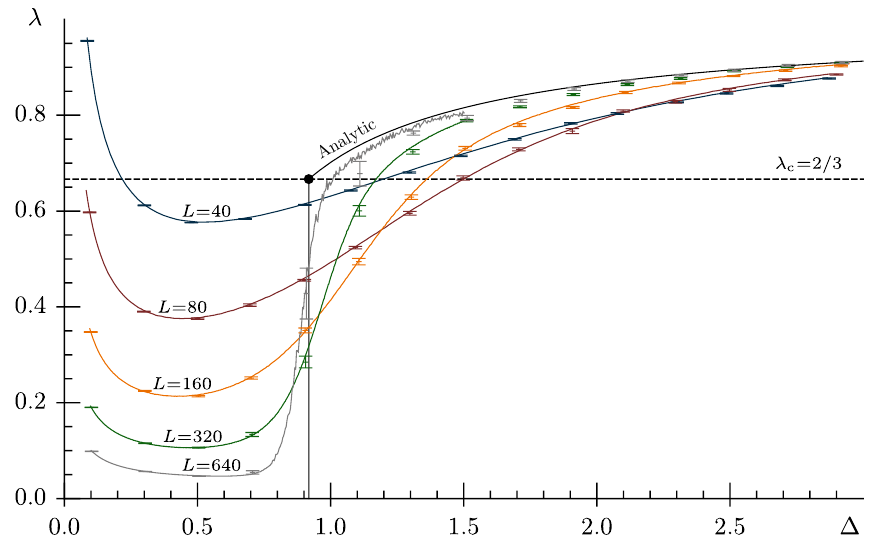
Figure 7: Droplet formation-dissolution transition at fixed T = 0.4, expressed in terms of the density parameter ∆ ( ρ , V ) and the droplet fraction λ ( ρ , V , N clude leading-order finite-size corrections. Individual points with error bars stem from M ETROPOLIS simulations and continuous lines are reweighted from M UGC . Strong finite-size effects are apparent in the gas phase but with respect to ∆ data convincingly approaches the analytic prediction. The intersection with the hori- = 2 / 3) is subsequently used to further investigate higher-order zontal dashed line ( λ c